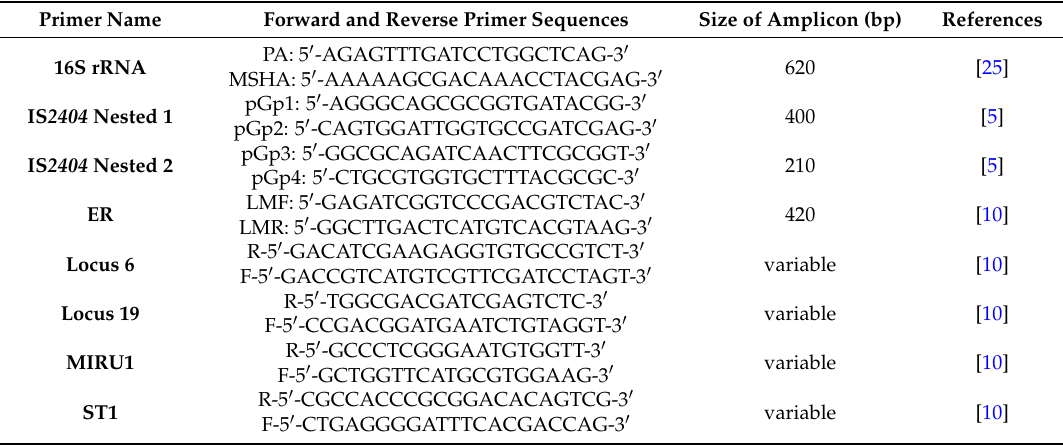
Table 1. Specific primers used for identification of non-tuberculous